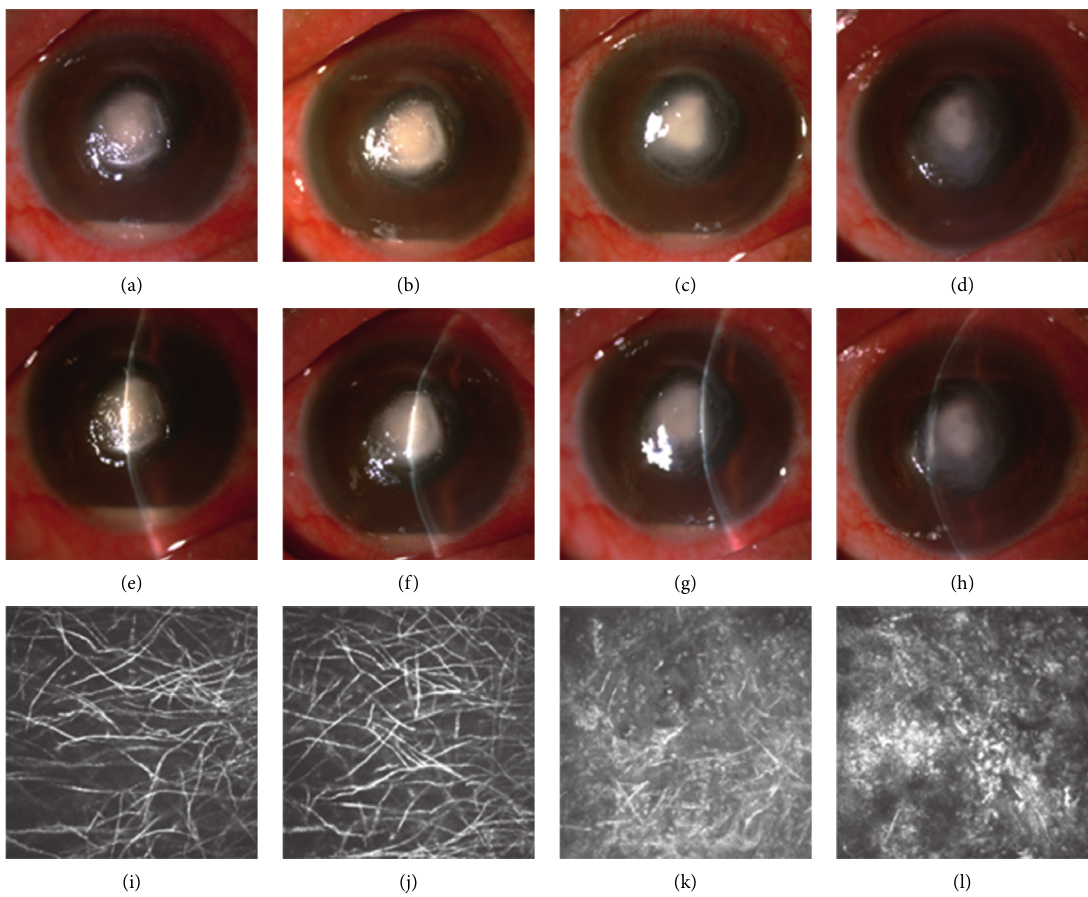
Figure 2: Case 1. (a, e) Anterior segment photograph at enrollment. (b, f) Anterior segment photograph before TCSI (after 5-day conventional antifungal treatment). (c, g) Anterior segment photograph 3 days after TCSI. (d, h) Anterior segment photograph when the patient has been healed. (i) IVCM examination at enrollment. (j) IVCM examination before TCSI (after 5-day conventional